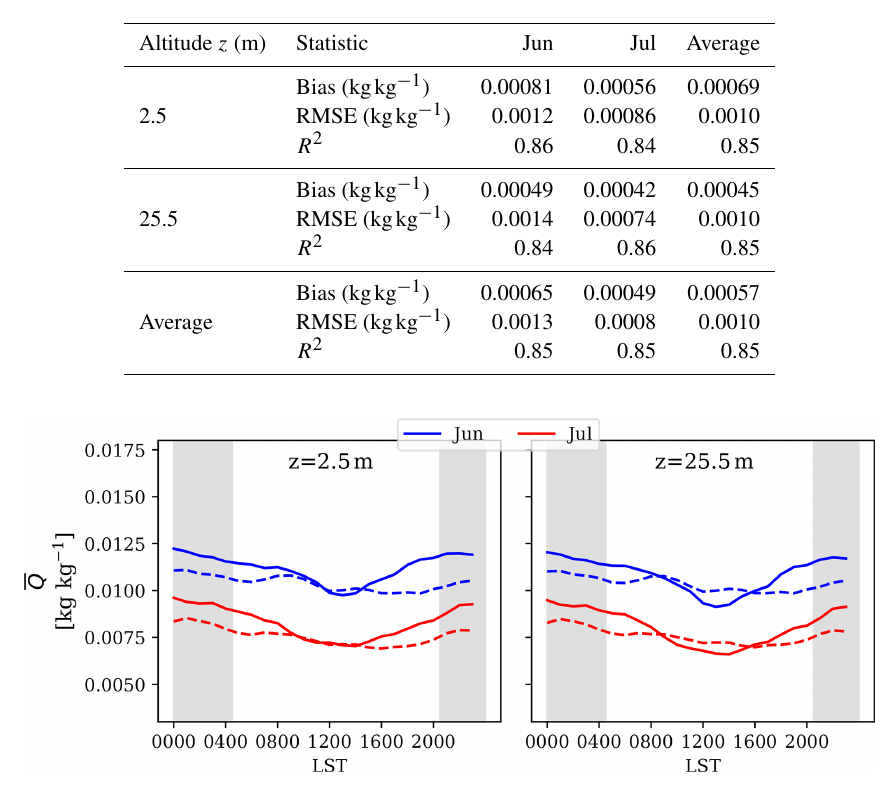
Figure 7. Comparison between the observed (BUBBLE) versus simulated (VCWG) values of specific humidity. The hourly means are shown, and nighttime is indicated by shaded regions. Solid line: model, dashed line: observation. Times are in local standard time